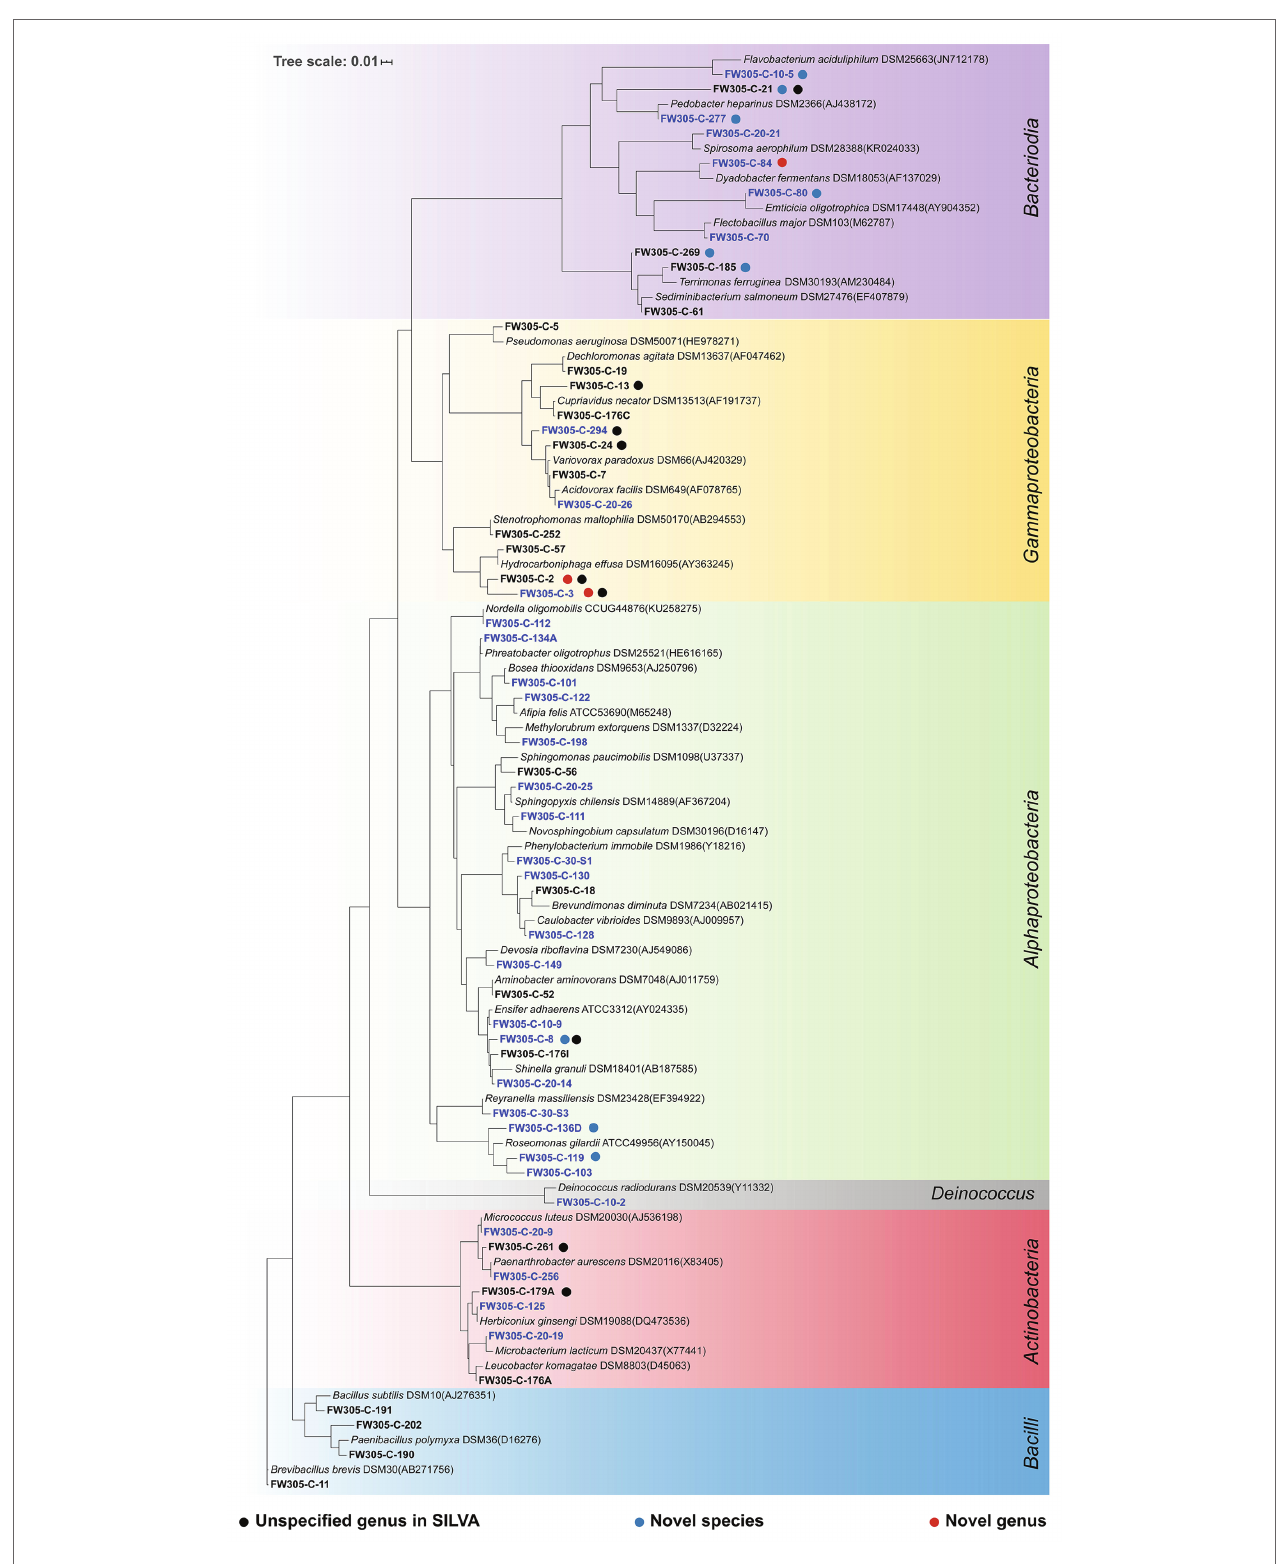
FIGURE 5 | Phylogenetic tree of representative isolates representing 56 distinct bacterial species. The tree is constructed from near full-length 16S rRNA gene sequences. Unspecified genus in SILVA (black), novel candidate species (blue), and novel candidate genus (red) are shown by dot colors. The fonts in blue are those isolated from sediment DOM-amended enrichments and those in black from cell lysate-amended